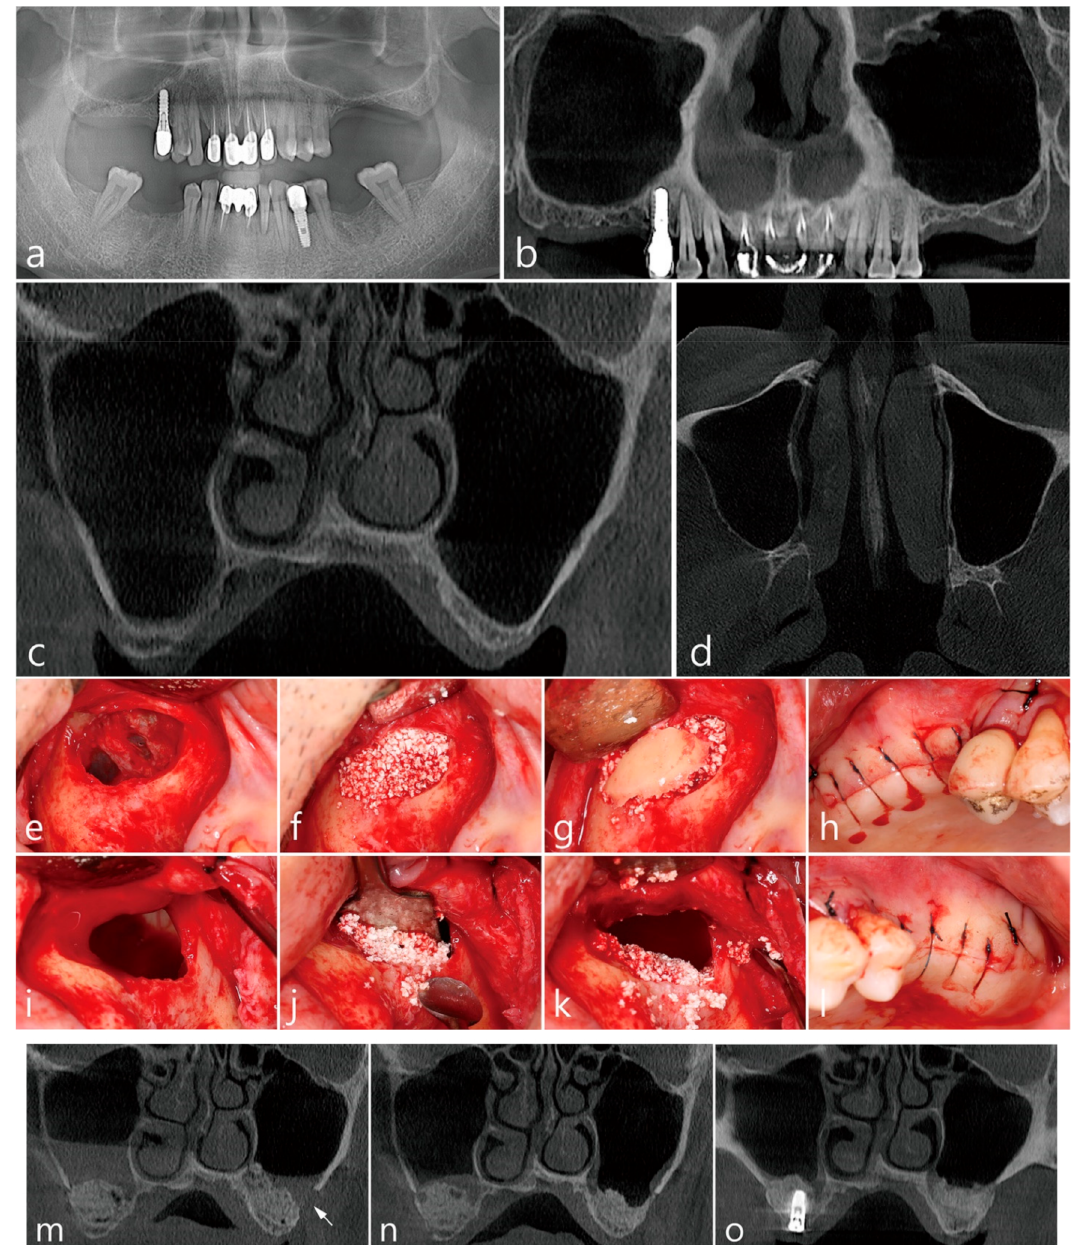
Figure 2. Case 2. Radiological findings of case 2. ( a ) On the panoramic radiograph before the procedure, pneumatization of the left and right maxillary sinuses and insufficient residual alveolar bone was observed; ( b ) Membrane thickening was not observed in the left and right maxillary sinuses on the panoramic image of the preoperative CBCT; ( c ) In the coronal image of the preoperative CBCT, the Schneiderian membrane was very thin and the buccal bone was not thick; ( d ) In the axial image of the preoperative CBCT scan, sinus membrane thickening was not found. Clinical picture of the lateral window approach with unintentional split-mouth design. ( e ) A lateral window approach performed in the right maxillary sinus without perforation of the Schneiderian membrane. After removal of the lateral bone window, the sinus membrane was separated from the sinus floor and elevated; ( f ) The MSA was performed. ( g ) The lateral bone window was repositioned; ( h ) The flap was closed; ( i ) An open lateral window approach performed on the left maxillary sinus with wide perforation of the Schneiderian membrane. The Schneiderian membrane was widely perforated during sinus floor elevation; ( j ) The Prichard elevator was placed in the maxillary sinus, and bone grafting was